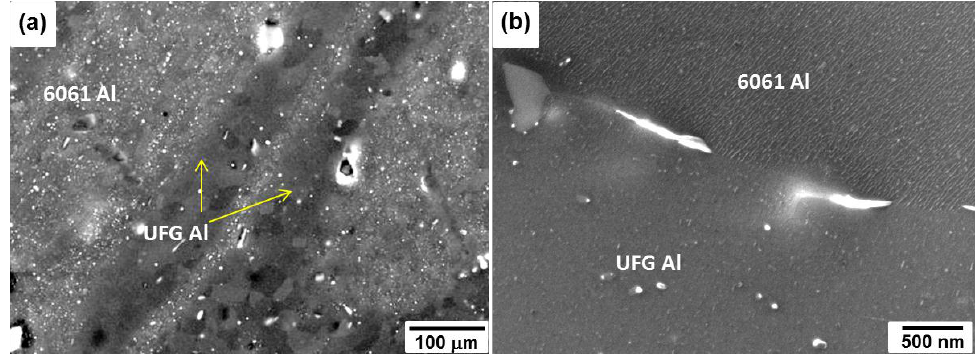
Figure 6. SEM (scanning electronic microscopy) images showing the mixing of the two kinds of aluminum alloys in the stir zone. ( a ) Alternative layered structure of the two materials; ( b ) interfacial microstructure between the UFGed 1050/6061-T6 aluminum alloys.